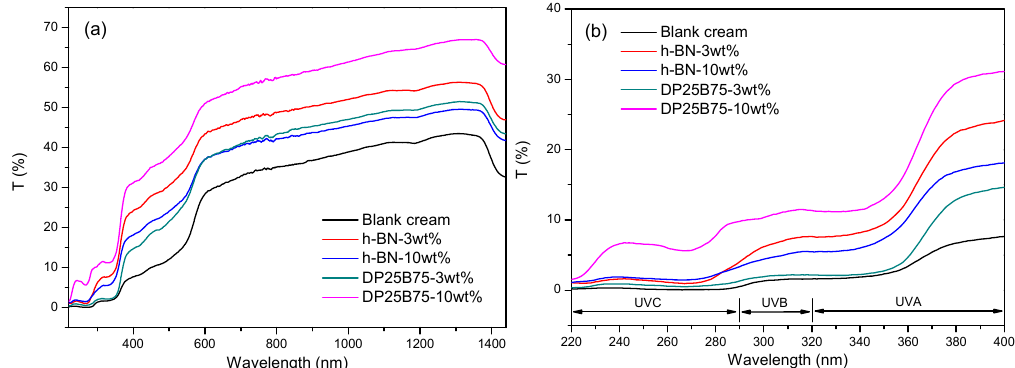
Figure 7. ( a ) UVC-near infrared (220–1440 nm) and ( b ) UVC-UVA (220–400 nm) spectra of BB creams with or without h-BN and DP25B75 powder.